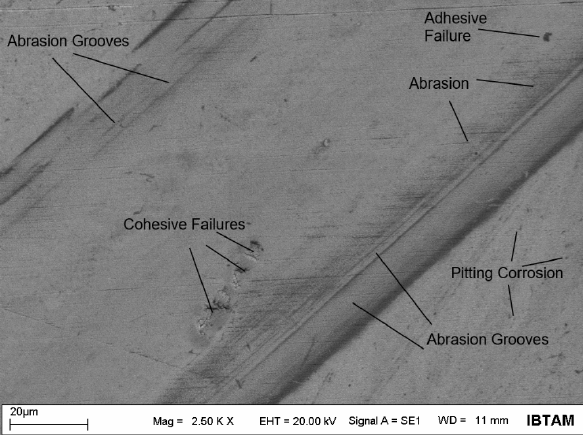
scratches on the rims of the wear tracks are not related to wear test and probably formed from the polishing